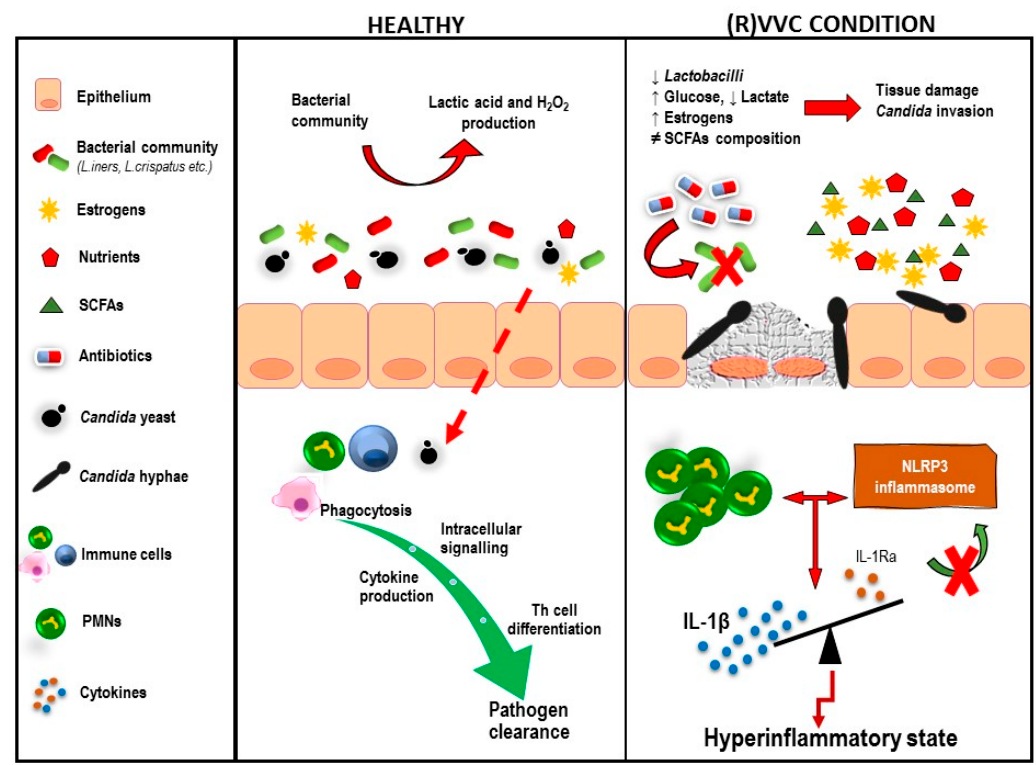
Figure 2. Environmental and immunological components that contribute to the host overreaction during RVVC.